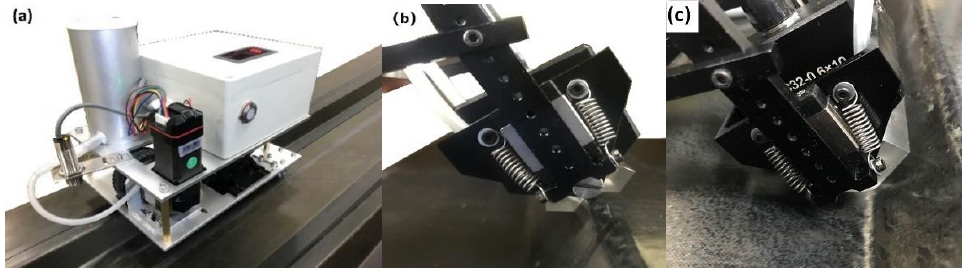
Figure 19. Non-destructive testing and sound field verification device on stringer through phased